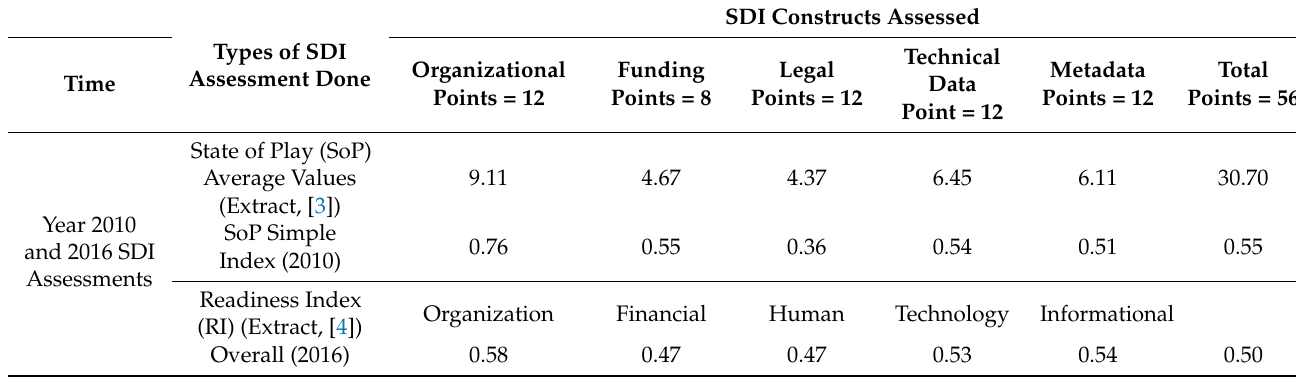
Table 1. Extracts from continental Africa spatial data infrastructure (SDI)